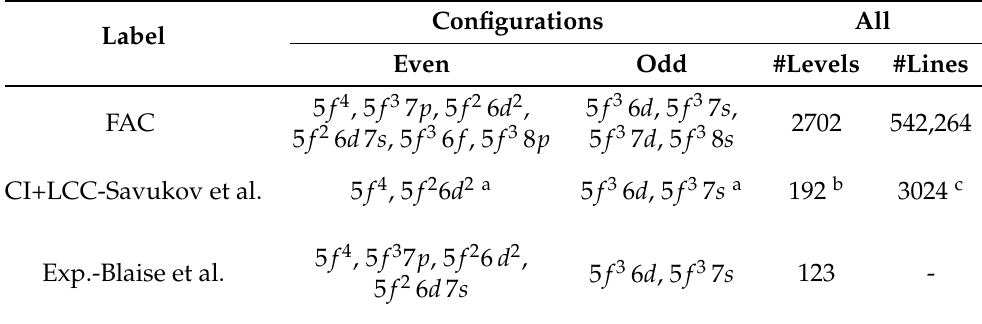
Table 2. Summary of the different set of configurations used on the FAC calculation for U III. An overview of the experimental data from Blaise et al. [23]. The calculations produced by Savukov et al. [26] using a hybrid configuration interaction (CI) plus linearized coupled cluster (LCC) methods (described in [27]) are also shown. For the CI+LCC calculations, we only show the configurations for which levels and lines data were